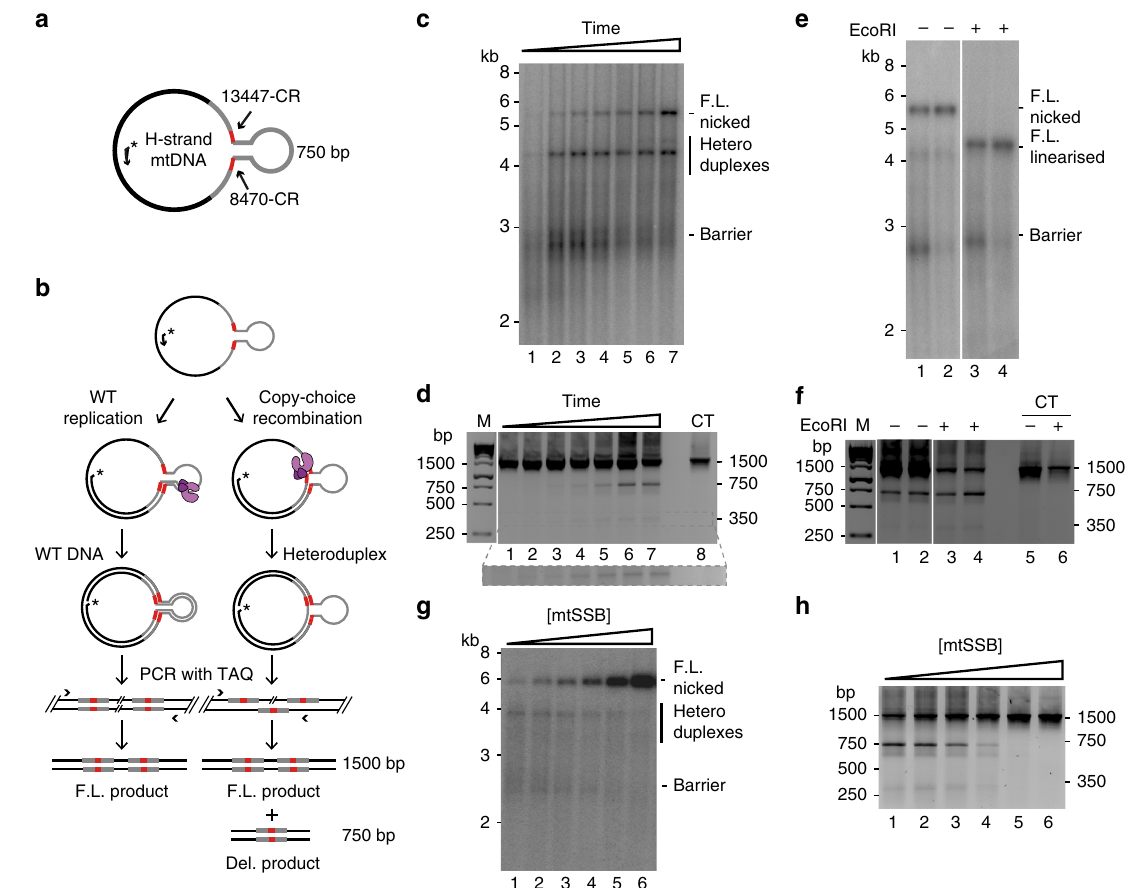
Fig. 2 Deletion formation during L-strand synthesis. a Schematic representation of the barrier template (T1). The template contains two stretches of the mtDNA H-strand (each stretch ∼ 600 bp, indicated in grey) including the 13-bp common repeats, 8470-CR and 13447-CR (indicated in red). A GC-rich inverted repeat is inserted at the 3 ′ -end of 8470-CR and 5 ′ -end of 13447-CR to form a hairpin structure that functions as a replication barrier. A 32 P- labelled primer for initiation of L-strand synthesis is annealed to the ssDNA template. b Schematic representation of the assay. POL γ (purple) initiates L-strand synthesis from a 32 P-labelled primer. If copy-choice recombination occurs during replication, a heteroduplex molecule is formed, containing one full-length H-strand and a deleted L-strand. The heteroduplex can be identi fi ed by PCR analysis, generating a shorter PCR product (750 bp) in addition to the full-length product of 1500 bp. c A time course (2.5, 5, 10, 15, 20, 30, 60 min) experiment of L-strand mtDNA synthesis was performed as described in Methods. The size markers are linearized dsDNA. d The reactions in panel c were analysed by PCR as described in panel b. The lower panel shows an expanded image of the boxed 350-bp region that has been further exposed. CT — control: single-stranded DNA template. e L-strand DNA synthesis incubated for 30 min (lanes 1 and 3) or 60 min (lanes 2 and 4) as in panel c , but before (lanes 1 and 2) and after EcoRI treatment (lanes 3 and 4). f The reactions in panel e were analysed by PCR. The double-stranded barrier plasmid before (lane 5) and after linearization with EcoRI (lane 6) was used as a control (CT). g L-strand DNA synthesis was performed as in panel c, but in the presence of increasing mtSSB concentrations (0, 0.5, 1.25, 2.5, 5, 12.5 nM calculated as tetramers). h The reactions in panel g analysed by PCR. Source data are provided as a Source Data fi